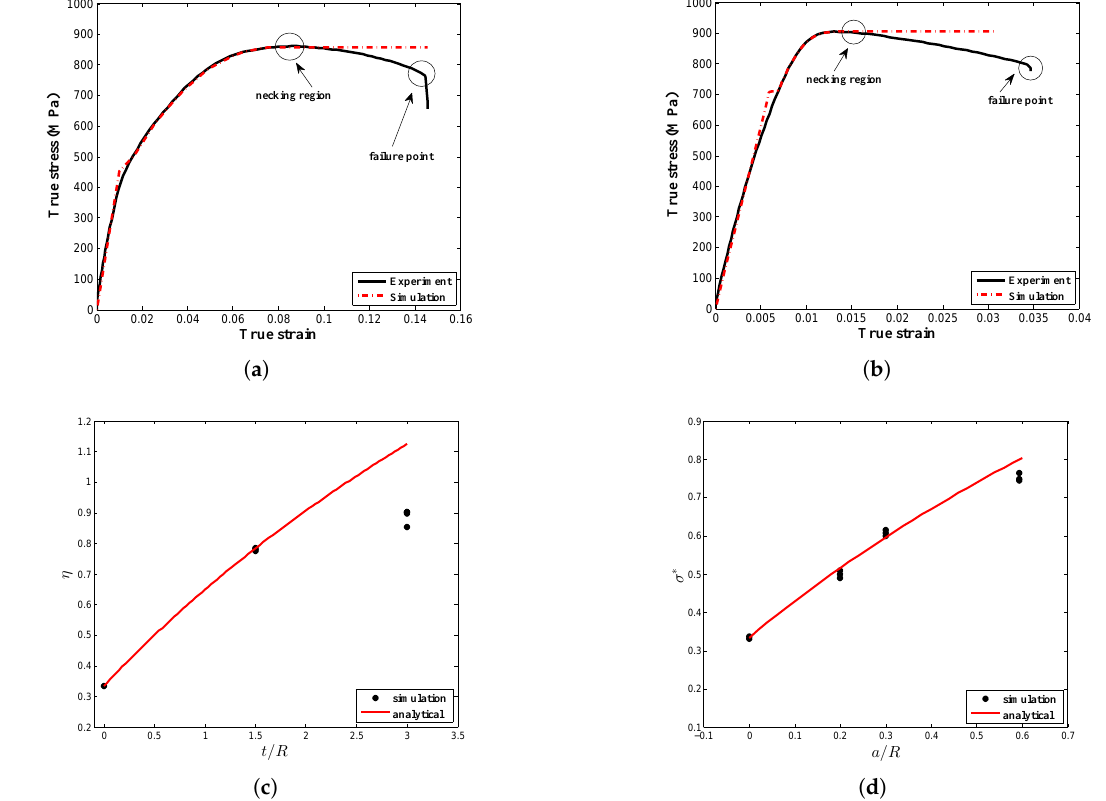
Figure 9. Flow stress curve at room temperature for AISI-1045 steel. ( a ) Comparison plot of the stress ∼ strain curve between experimental results and simulation results of the round bar specimen; ( b ) Comparison plot of the stress ∼ strain curve between experimental results and simulation results of the round bar notched specimen; ( c ) Comparison results of Bao and co-workers’ equation and numerical simulation; ( d ) Comparison results of the Bridgman equation and numerical simulation.